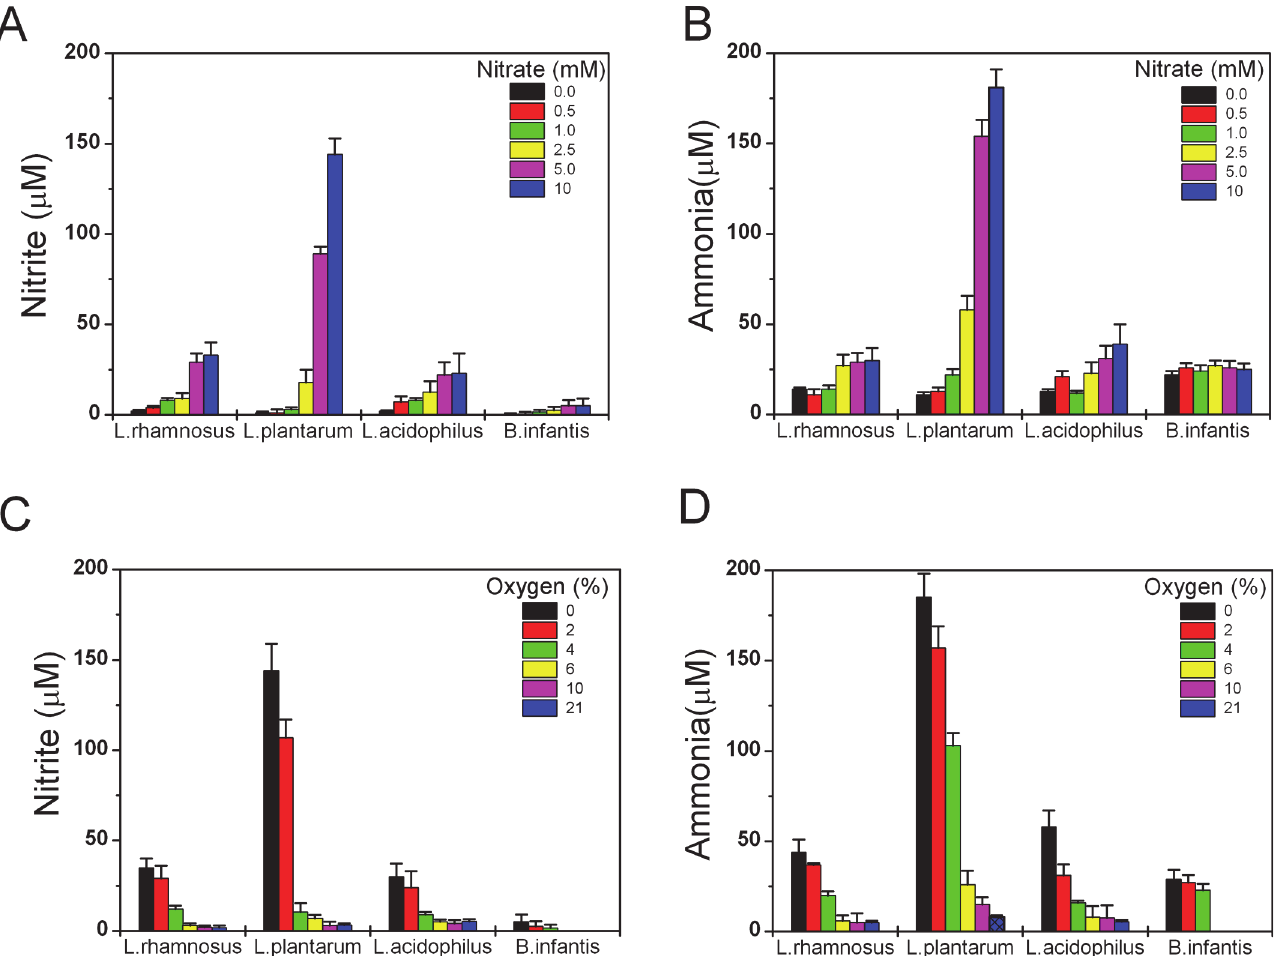
Fig 2. The effect of nitrate and oxygen gradients on the generation of nitrite and ammonia in different LAB cultures. Nitrite (A) and ammonia (B) concentrations were measured in LMRS media after 24 h growth at 2% O 2 with supplementation of different nitrate concentrations (0 to 10 mM). Similarly in (C) and (D) nitrate was fixed at 5 mM and we measured nitrite and ammonia dependence on oxygen concentrations (0, 2, 4, 6, 10 and 21%). Each point represents the mean ± SD (n =